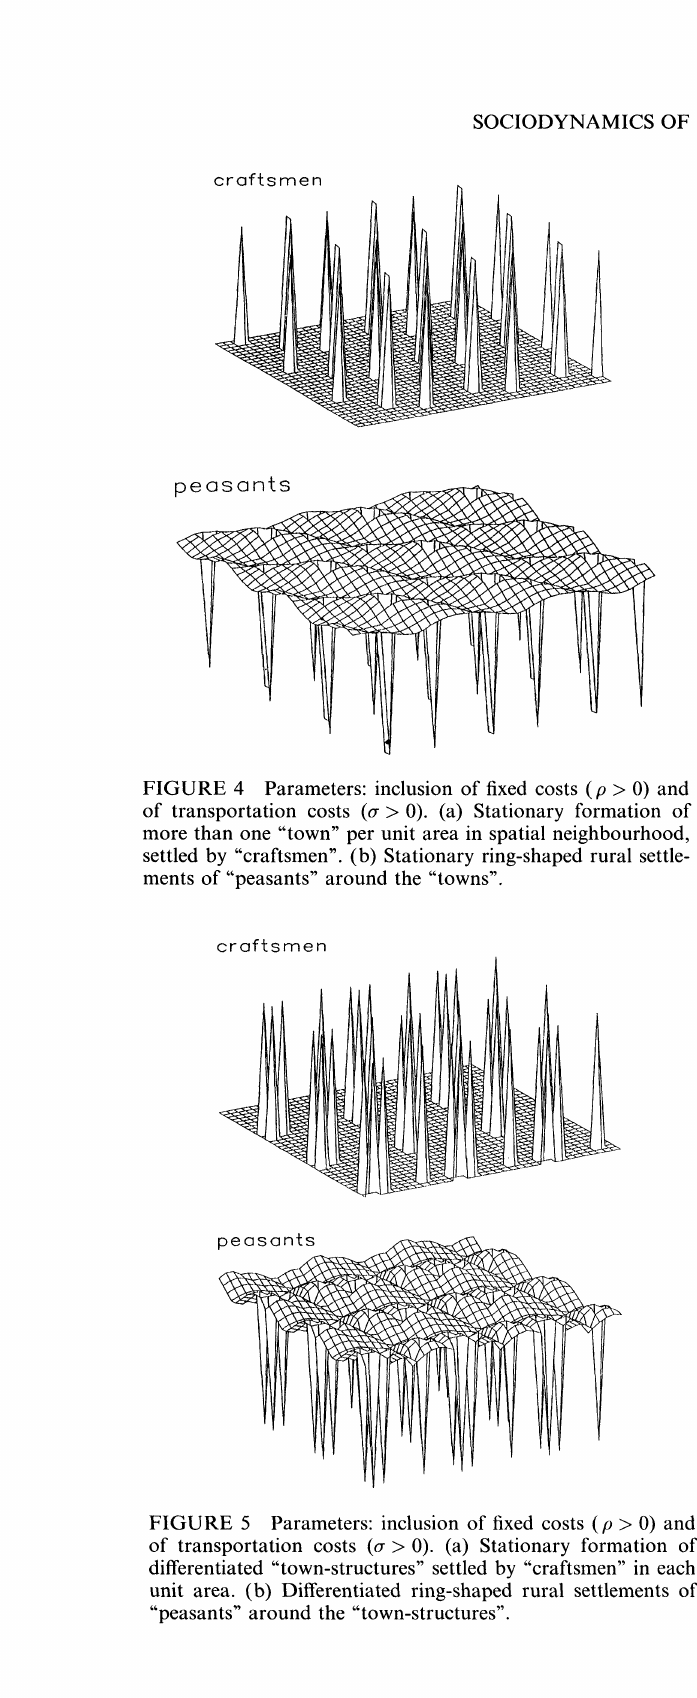
FIGURE 5 Parameters: inclusion of fixed costs (p > 0) and of transportation costs (a > 0). (a) Stationary formation of differentiated "town-structures" settled by "craftsmen" in each unit area. (b) Differentiated ring-shaped rural settlements of "peasants" around the